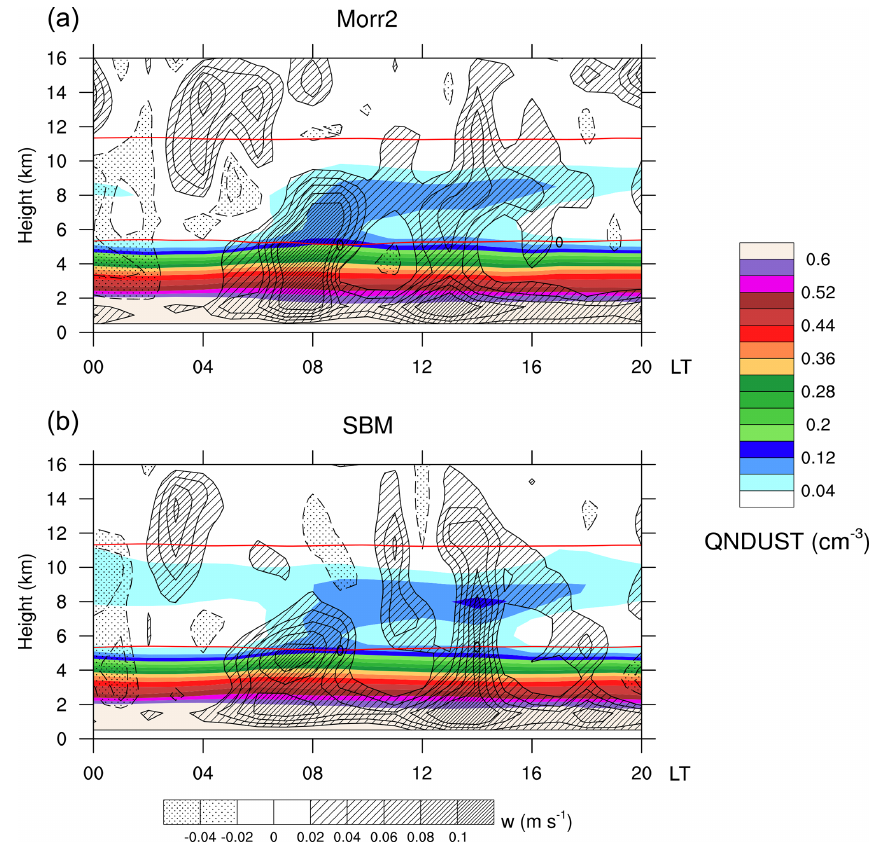
Figure 10. Time series of dust number concentration (shaded) and temperature (red line) and vertical velocity (contours) averaged among precipitation grids ( > 0mmh − 1 ) in the High-Pcp area from (b) Morr2-Dusty and (c) SBM-Dusty.